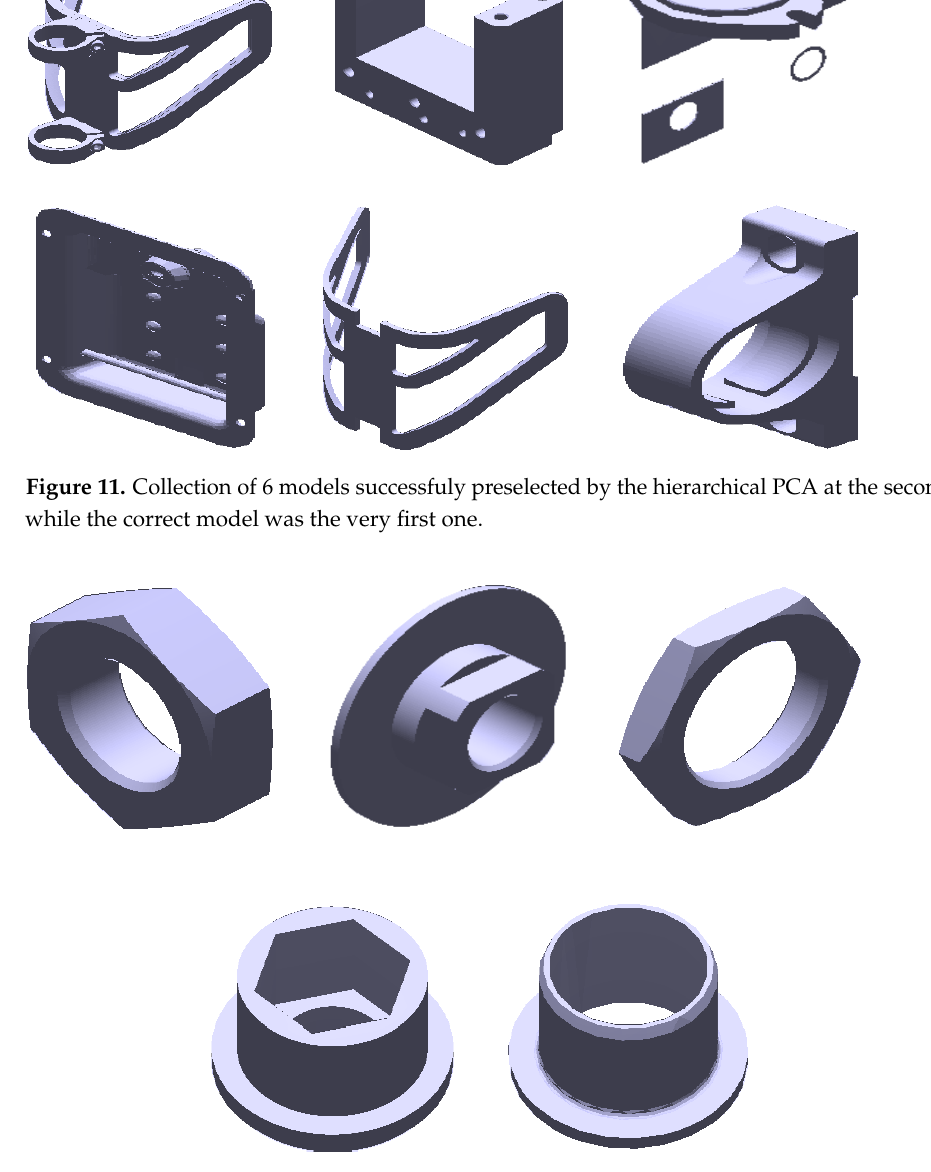
Figure 12. Collection of models among which the PCA cannot distinguish, but it includes the correct model, which is the second